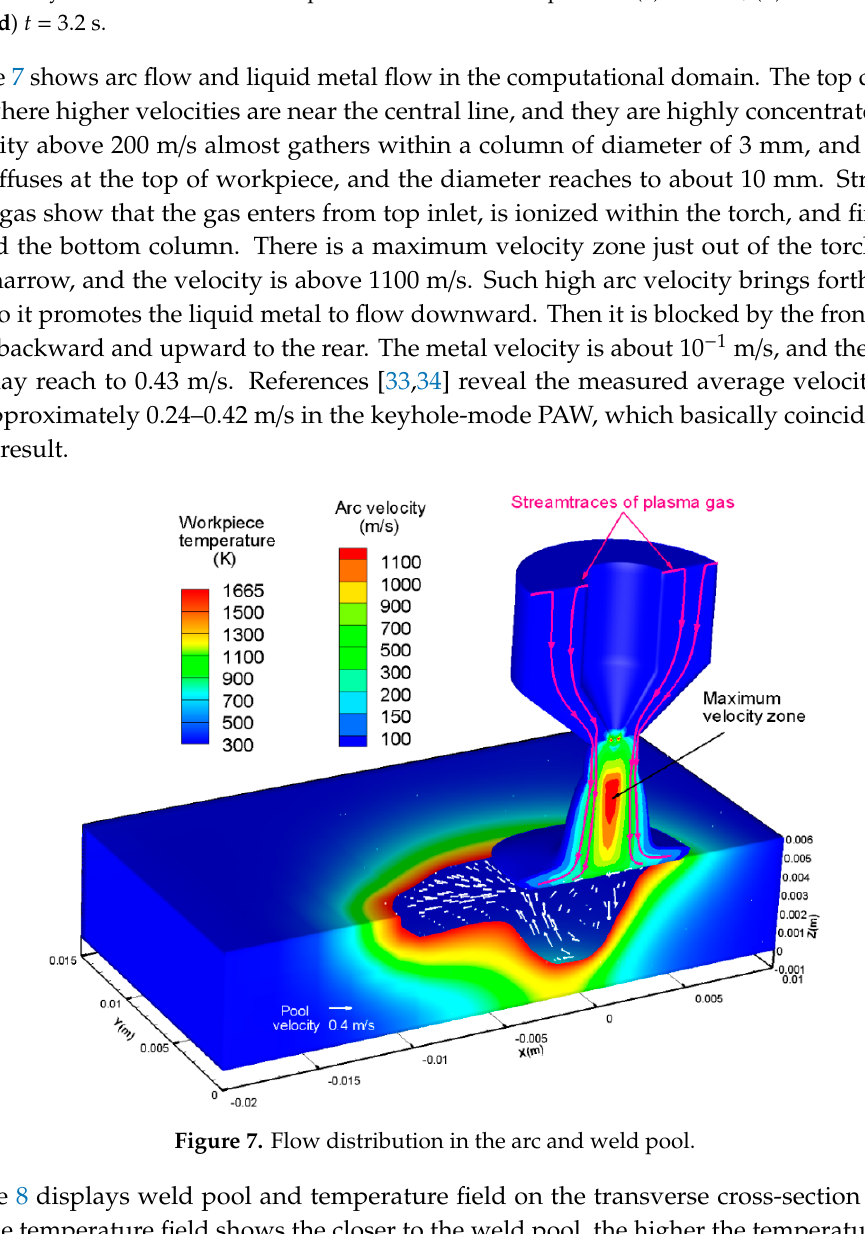
Figure 7. Flow distribution in the arc and weld pool.